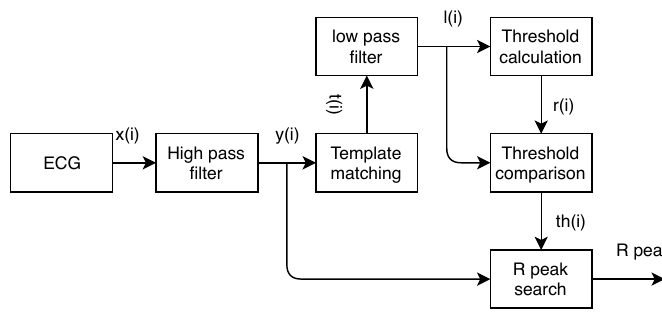
Figure 1. The proposed algorithm structure, consisting of six steps.